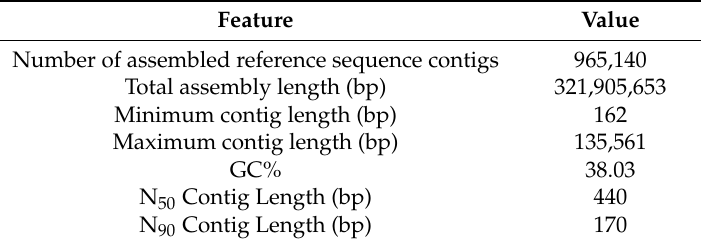
Table 4. Result of paired-end RAD-seq assembly statistics.